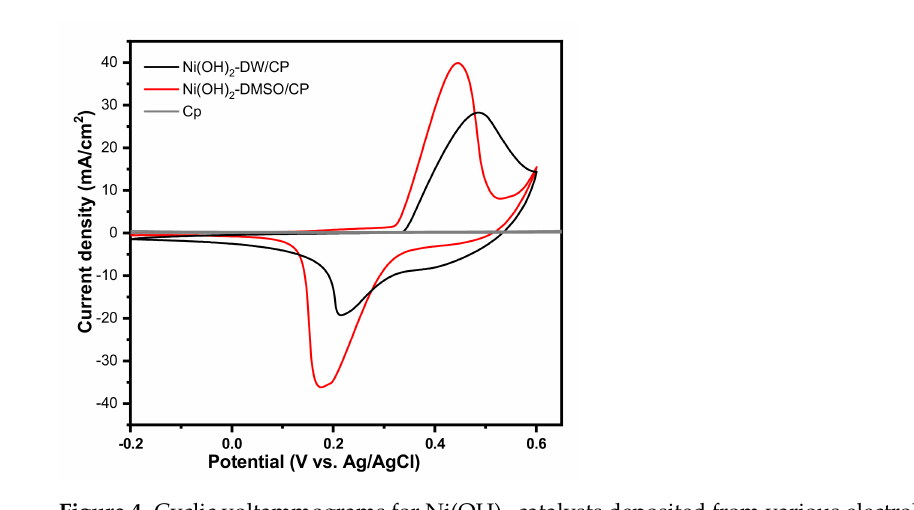
Figure 4. Cyclic voltammograms for Ni(OH) 2 catalysts deposited from various electrolytes: DMSO and DW at scan rate 50 mV/s in 1.0 M